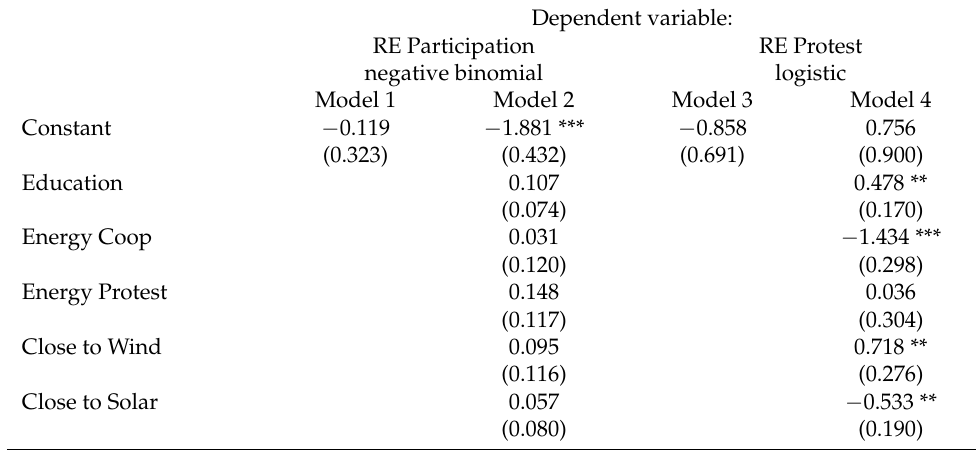
Table 3. Binary Logistic and Negative Binomial Regression Estimates of Energy